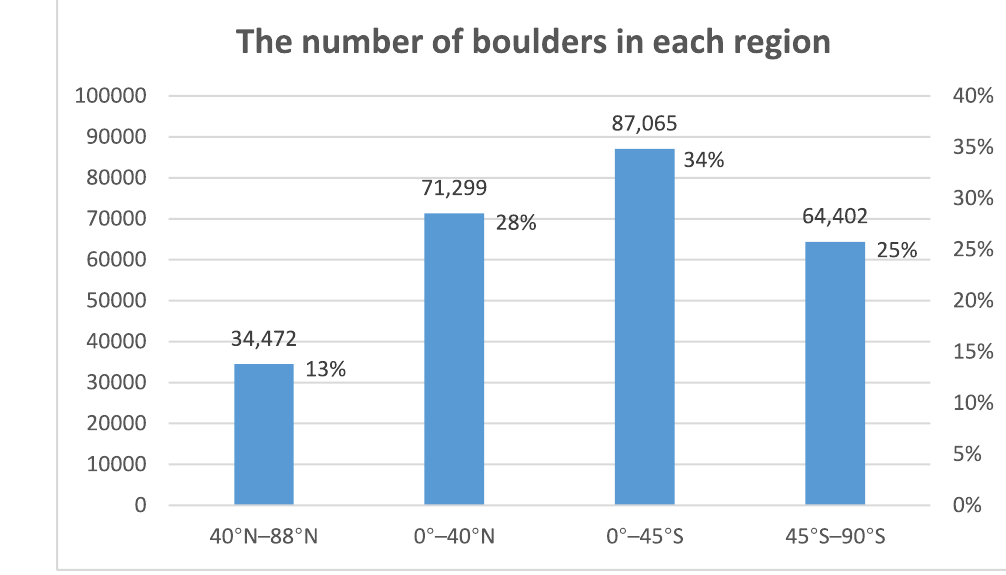
Figure 6. The number and proportion of boulders in each